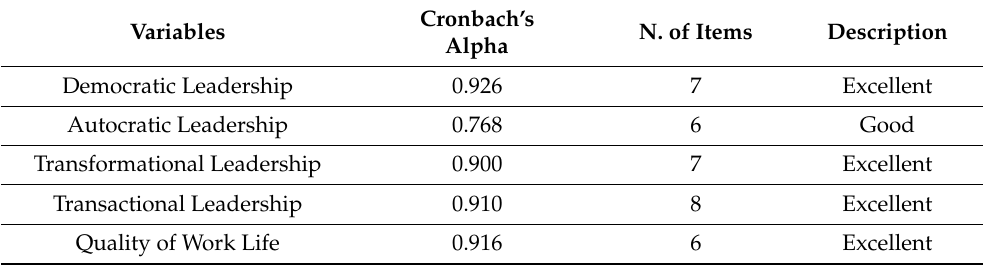
Table 1. Reliability Analysis.